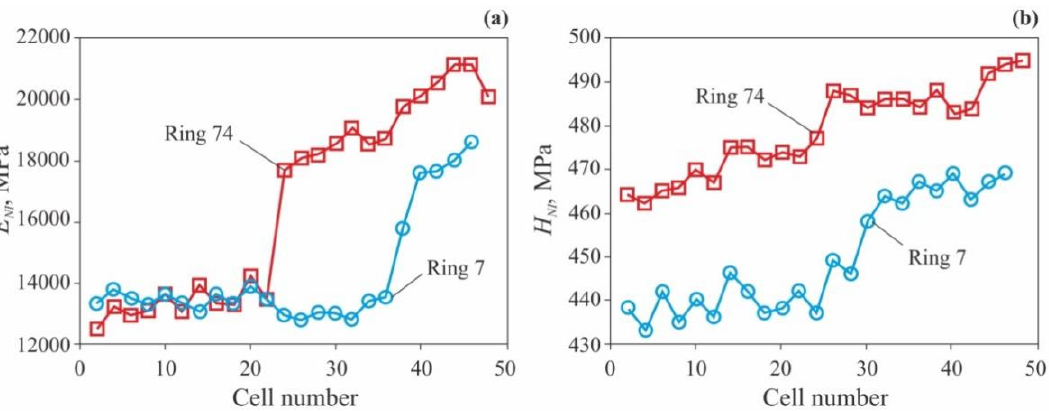
Figure 9. Dependencies of cell wall longitude Young modulus E NI ( a ) and nanohardness H NI ( b ) upon cell sequential number in the annual growth ring for two rings with ages of 7 and 74 years. Adapted with permission from Ref. [74]. Copyright 2020, PAN